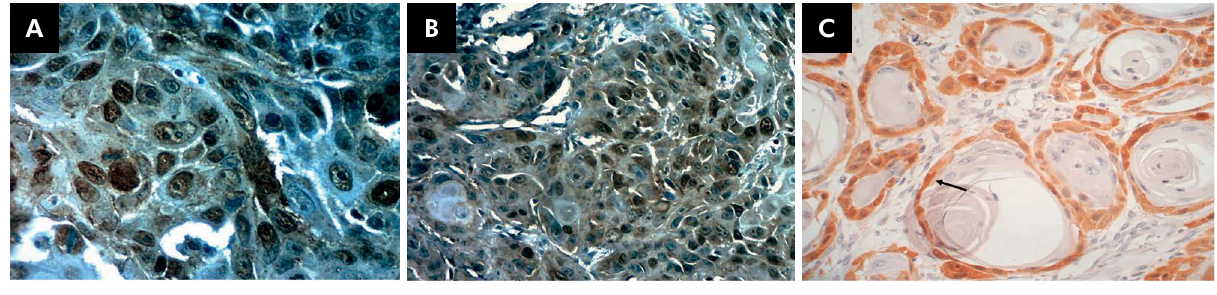
Figure 1. Immunoexpression of metallothionein protein in OSCC epithelium, nuclear immunostaining (x400 original magnification) (a). The immunostaining was located at the periphery and at the center of the tumor island (b). The immunostaining around the pearls of keratin